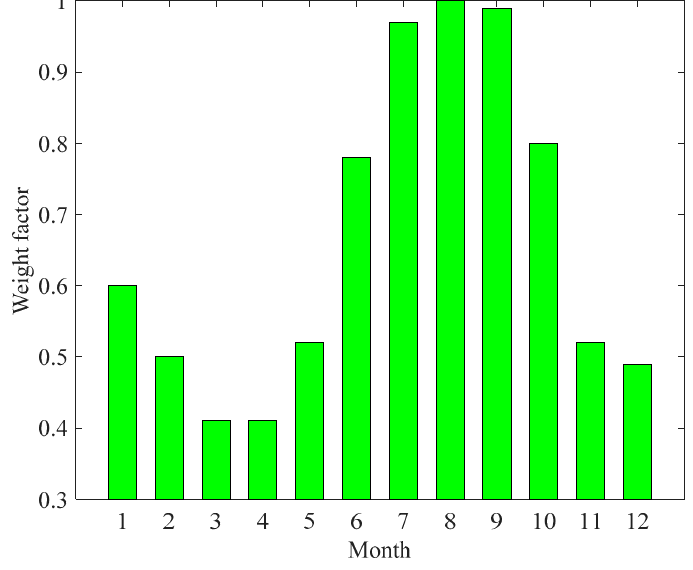
Figure 2. Monthly load factor curve.